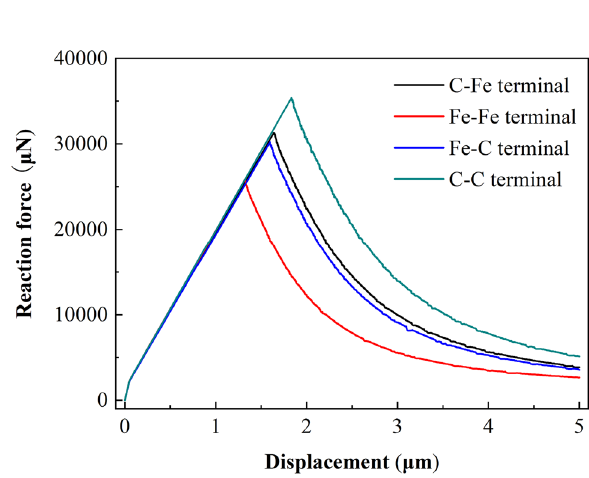
Figure 22. Displacement vs reaction force at loading point (500 μm × 480 μm).